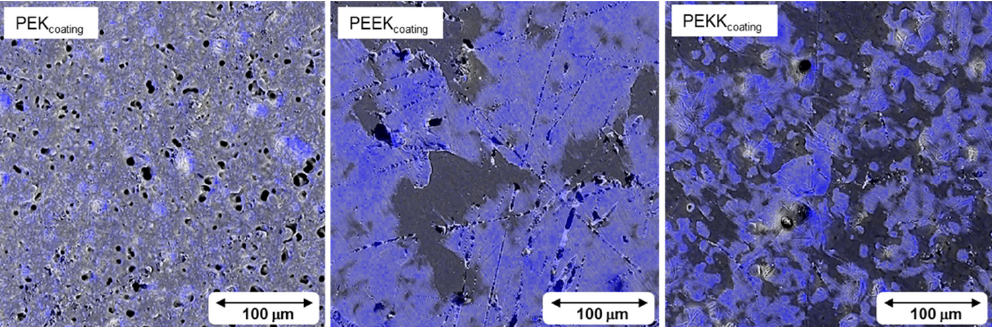
Figure 13. SEM images with EDS mapping of fluorine distribution (in blue) of each coating.